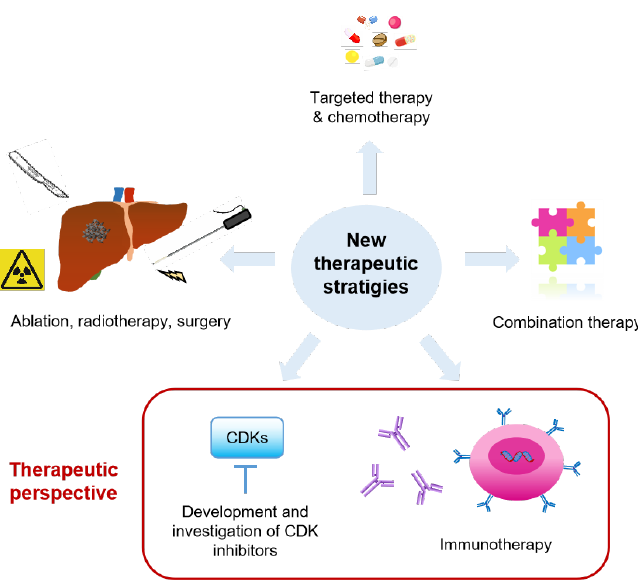
Figure 3. Therapeutic perspectives for colorectal cancer liver metastasis. Several new therapeutic strategies are under clinical trials, including: (1) novel or the combination of targeted therapy and chemotherapy, either locally or systemically; (2) ablation, radiotherapy, surgery; (3) the combina- tion of current therapies; (4) development and investigation of CDK inhibitors; (5) immunotherapy like immune checkpoint inhibitor, CAR-T cells, etc. Table 1. Ongoing clinical trials evaluating the use of different modalities in metastatic colorectal cancer. Recruitment Trial ID Phase Study Population Intervention Status